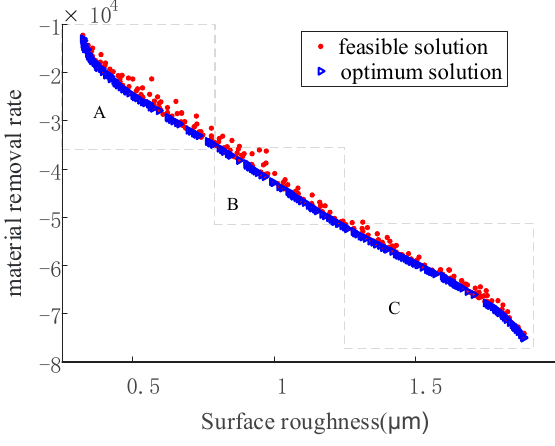
Figure 14. Roughness and material removal rate optimize Pareto frontier. Table 7. Values of partial